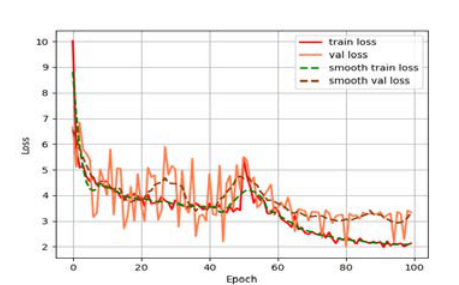
Fig. 3. YOLOX Loss curve.